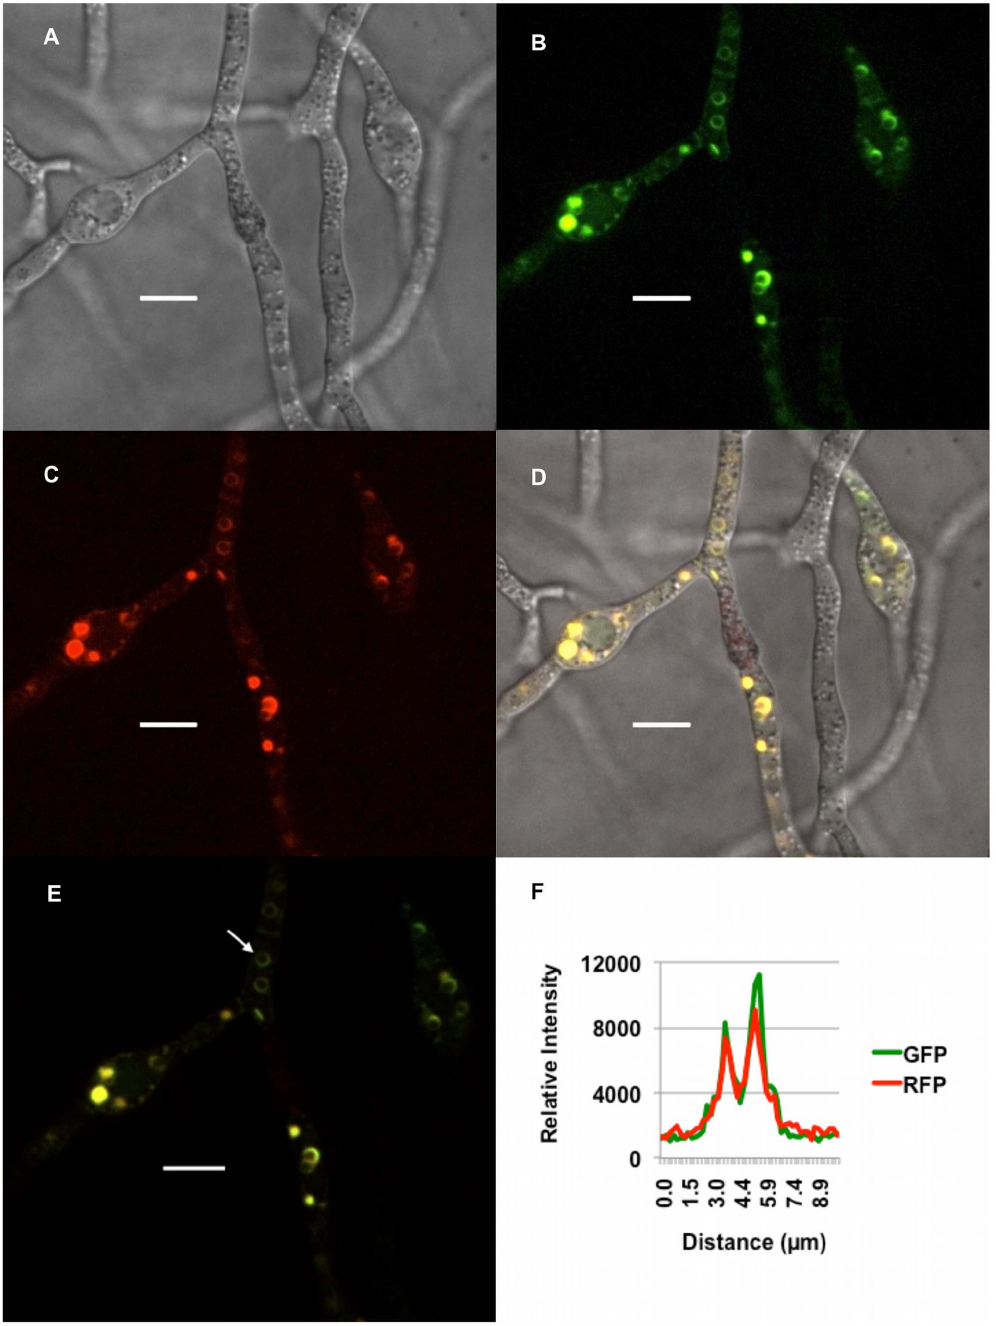
Figure 2. Co-localization of Tri1p and Tri4p to toxisomes. Strain PH-1Tri1::GFP/Tri4::RFP was incubated in TBI medium for 36 h. Confocal bright field DIC (A); GFP (B); RFP (C); and GFP/RFP/DIC (D) overlay images of toxigenic cells are shown. The arrow in the GFP and RFP overlay image panel (E) highlights co-fluorescence of GFP and RFP within the periphery of a spherical organelle. A graph of signal intensity of GFP and RFP emission spectra (F) generated from a line bisecting the spherical organelle shows spatial overlap of the separate emission fluorescence. Scale bar=10 m